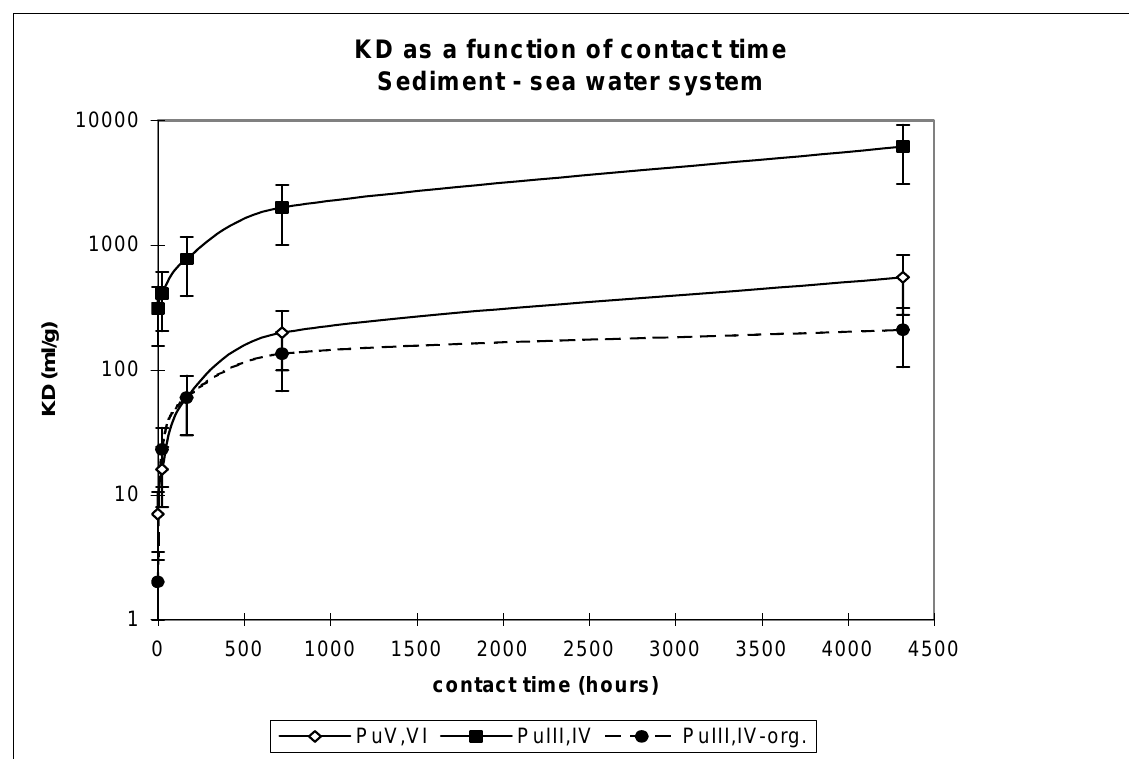
FIGURE 13 . K D as a function of contact time: Pu III,IV -ionic/colloidal, Pu III,IV -organic and Pu V,VI